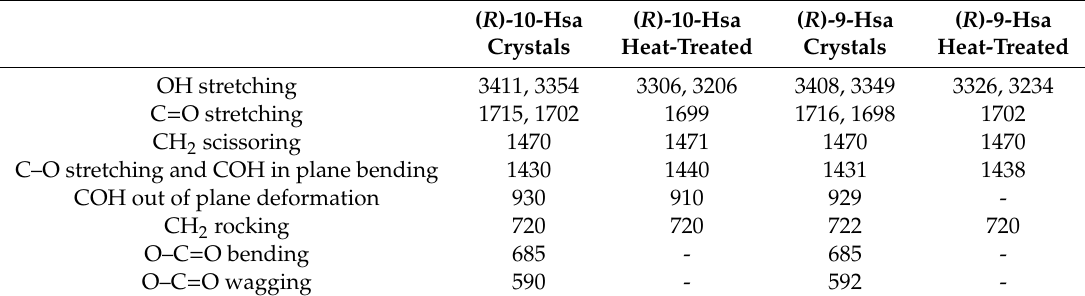
Table 1. IR bands with